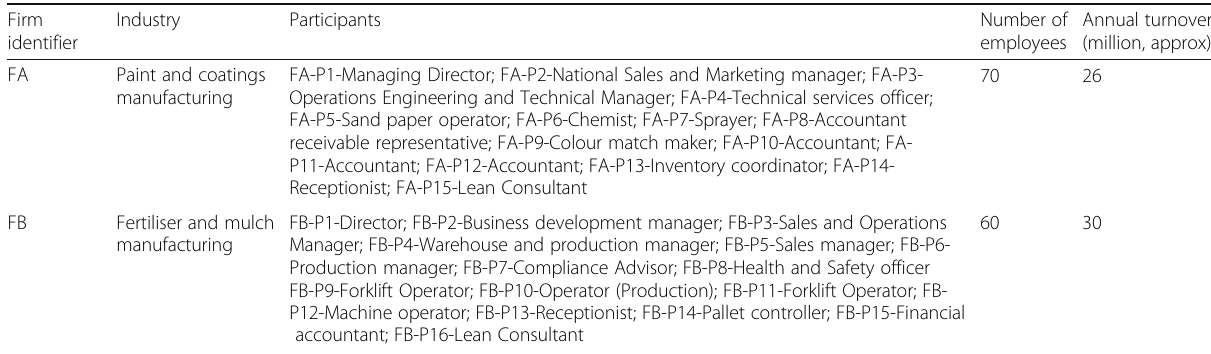
Table 2 Summary of SME participants a Firm